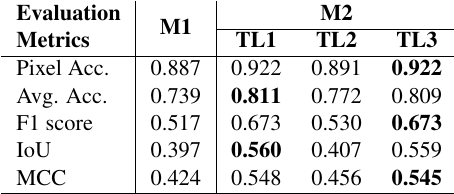
Table 3 . Cross-domain validation results on WHU Building dataset (TR1). M1 refers to the base model of modified U-Net that is trained on only the Melbourne Building dataset (TR2).